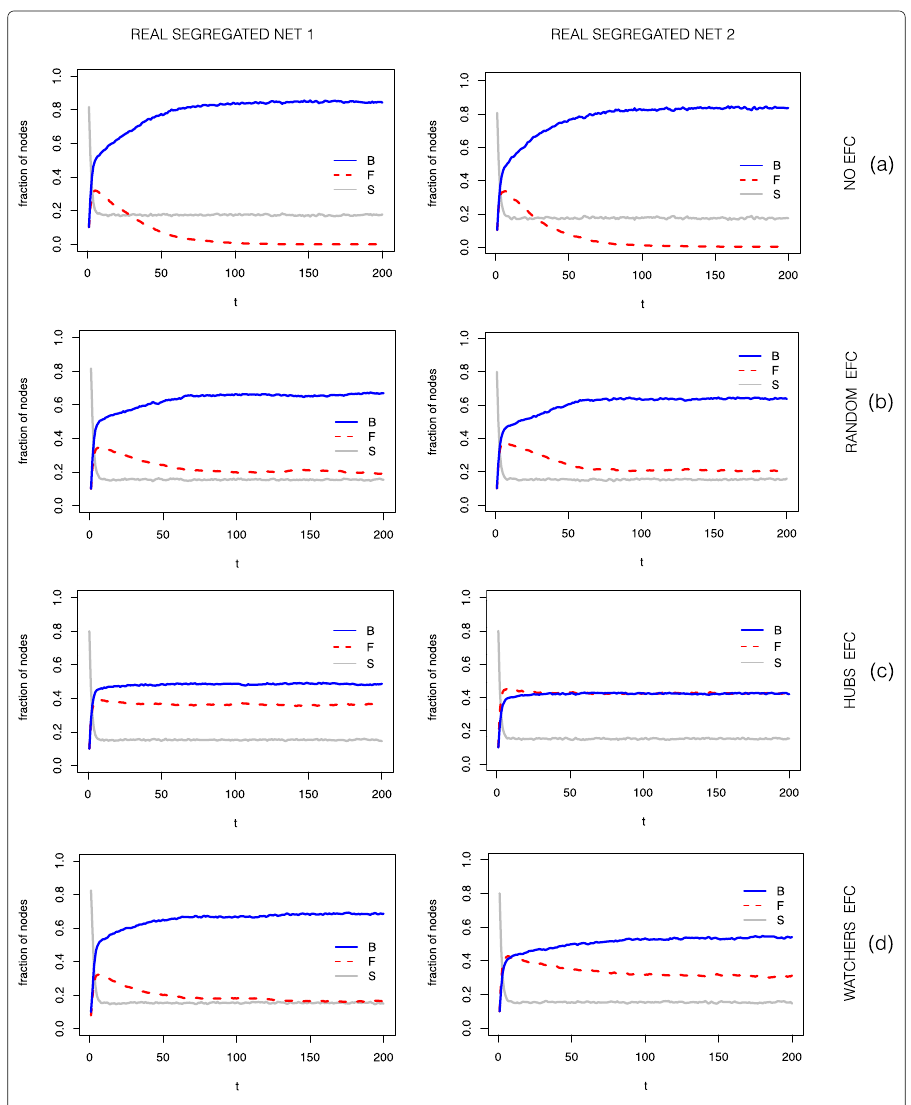
Fig. 8 Real Segregated Networks. Different strategies of choosing some nodes as eternal Fact Checkers (eFC) in a real segregated network (Adamic and Glance 2005) with skeptic and gullible communities: a no eFC, b eFC at random in the skeptic community, c eFC in the highest degree nodes of the skeptic community, d eFC on the frontier among the two communities (nodes in the skeptic group that are connected with nodes in the gullible one). The two columns represent two different assignment of gullible/skeptic communities to the labeled groups of the considered real network